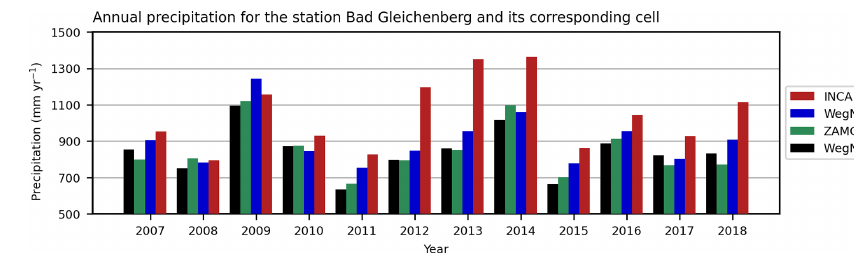
Figure B3. Annual precipitation for ZAMG Station 11244 (Bad Gleichenberg) and its corresponding cell.